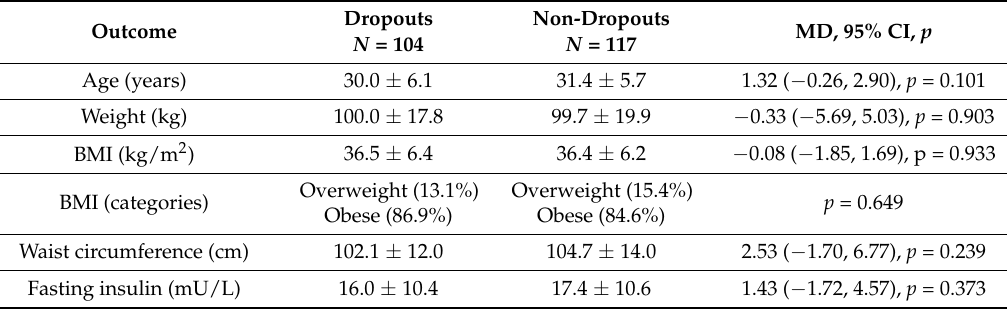
Table 2. Characteristics of study participants according to dropout